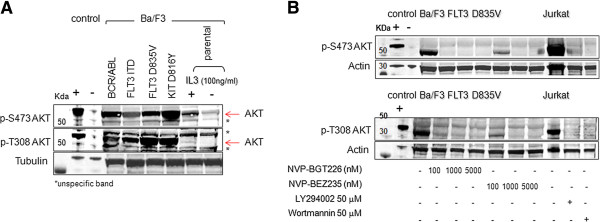
Western immunoblot analyses of mutant-TK Ba/F3 cells as a cell model for activated AKT-signaling. (A) Transfection of leukemia-driving mutant-KIT, FLT3 or BCR-ABL1 isoforms into a hematopoietic IL3-dependent Ba/F3 cell line leads to global increase of AKT phosphorylation as assayed by immunoblotting of whole cell extracts. Phosphorylation of Ser473 and Thr308 increases in response to IL3 stimulation - and further augments in cells transfected with a gain-of-function mutant-TK. Tubulin blotting is used as loading control. (B) An immunoblot experiment with Ba/F3 cells transfected with a FLT3 D836V mutation treated with NVP-BGT226 or NVP-BEZ235 and probed for phosphorylation patterns of AKT is shown. Jurkat cells are used as positive controls. Jurkat cells treated with PI3K inhibitors (Wortmannin, LY294002) serve as negative controls for AKT phosphorylation. Actin blotting serves as a loading control.